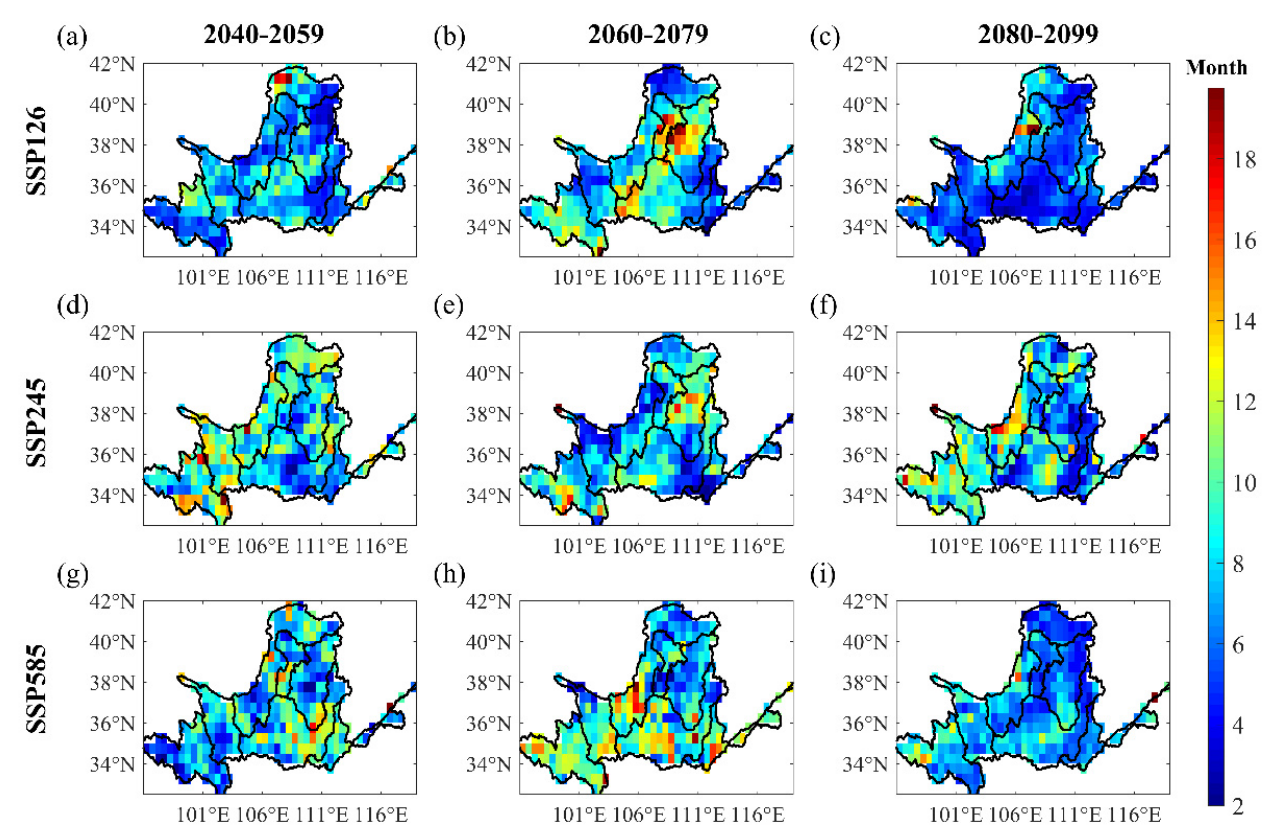
Figure 10. Spatial distribution of drought duration from SSP126, SSP245, and SSP585 over 2040– 2099 in the Yellow River basin. ( a – c ) are the drought duration of near future, middle future, far future under SSP126, ( d – f ) are the drought duration of near future, middle future, far future under SSP245, ( g – i ) are the drought duration of near future, middle future, far future under SSP585.